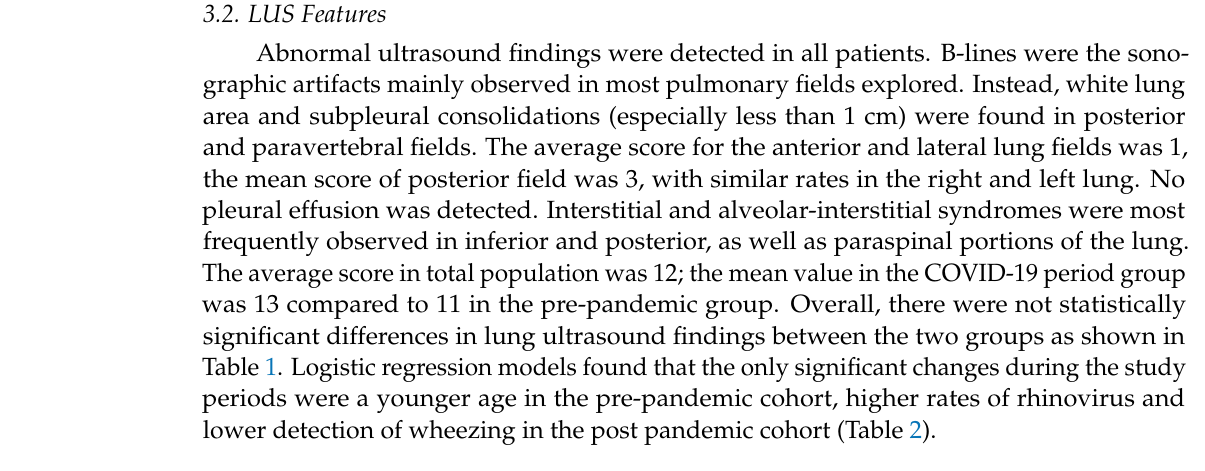
Table 2. Firth logistic regression model exploring the predictors associated with COVID-19